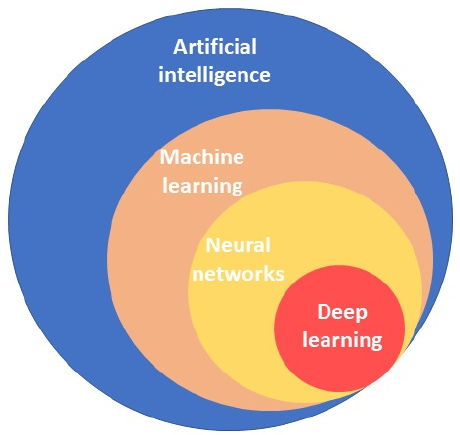
Figure 1. Primary concepts of artificial intelligence.